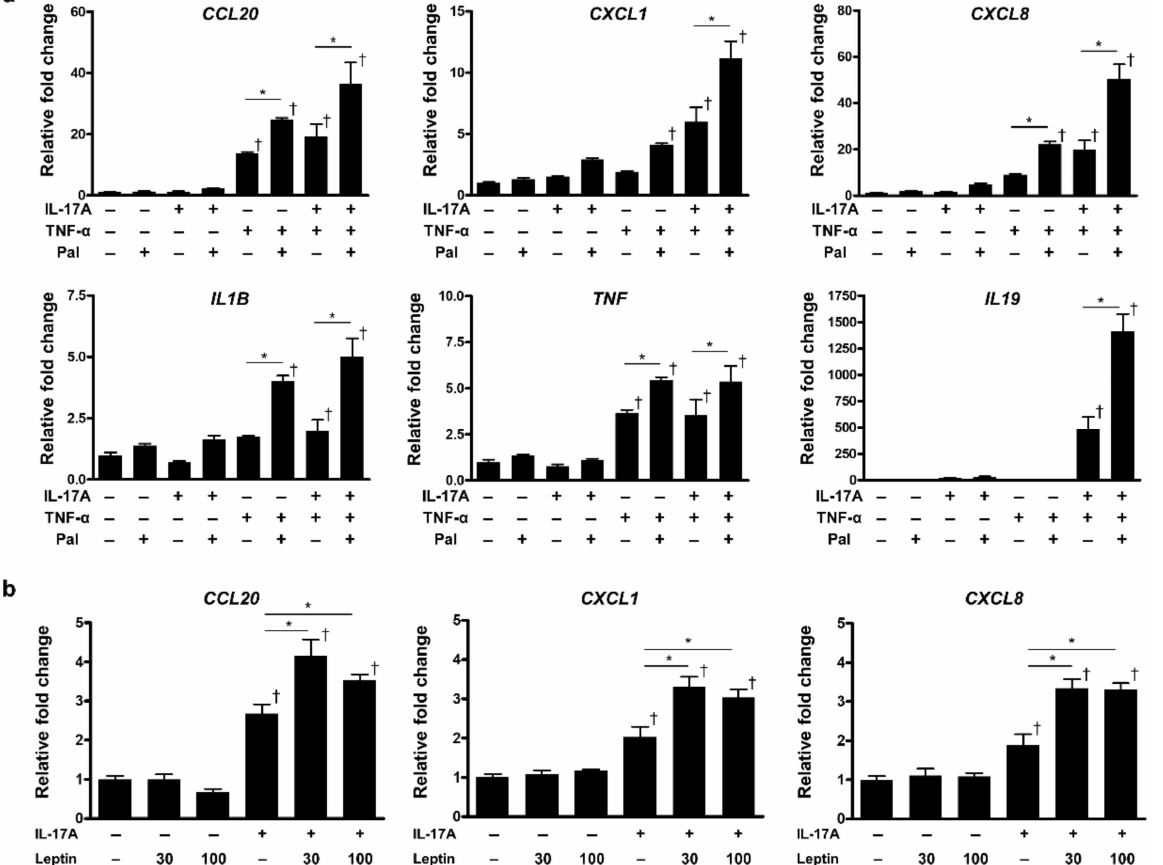
Figure 5. Effects of palmitic acid and leptin on epidermal keratinocytes: ( a ) mRNA expression after palmitic acid treatment. Normal human epidermal keratinocytes (NHEKs) were stimulated with IL-17A (30 ng/mL), TNF- α (30 ng/mL), and palmitic acid (Pal; 100 µ M) for 4 h. IL19 expression was determined after 24 h. ( b ) mRNA expression after leptin treatment. NHEKs were incubated with IL-17A (30 ng/mL) with/without leptin (30 or 100 ng/mL) for 24 h. Gene expression levels relative to GAPDH were calculated and normalized to those of non-stimulated controls. Values are presented as the mean ± standard deviation; * p < 0.05, † p < 0.05, compared to non-stimulated